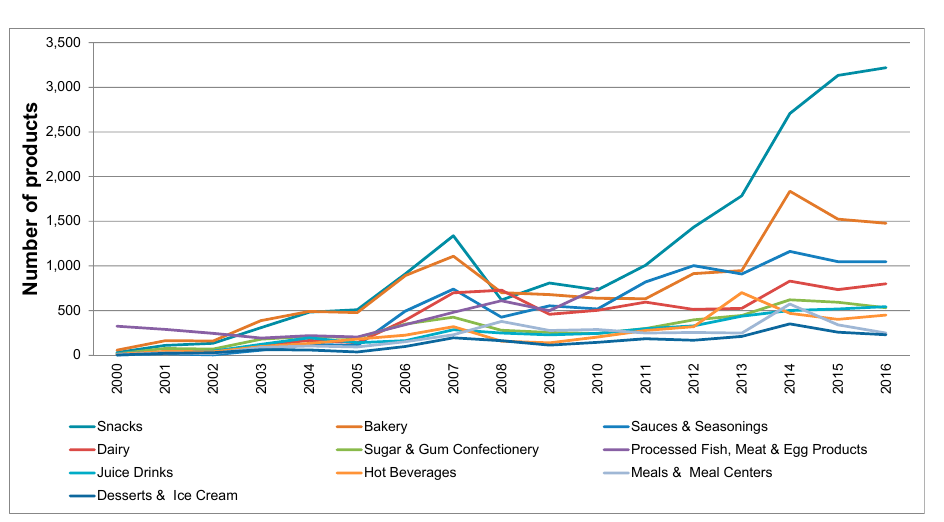
Figure 3. Number of products launched for the top 10 food and drink categories during 2000–2016. Source: Own elaboration based on Mintel’s GNPD data.